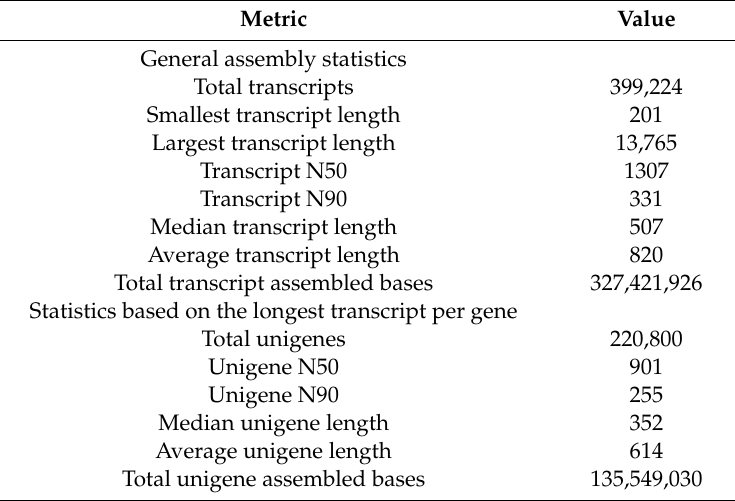
Table 1. De novo transcriptome assembly statistics for